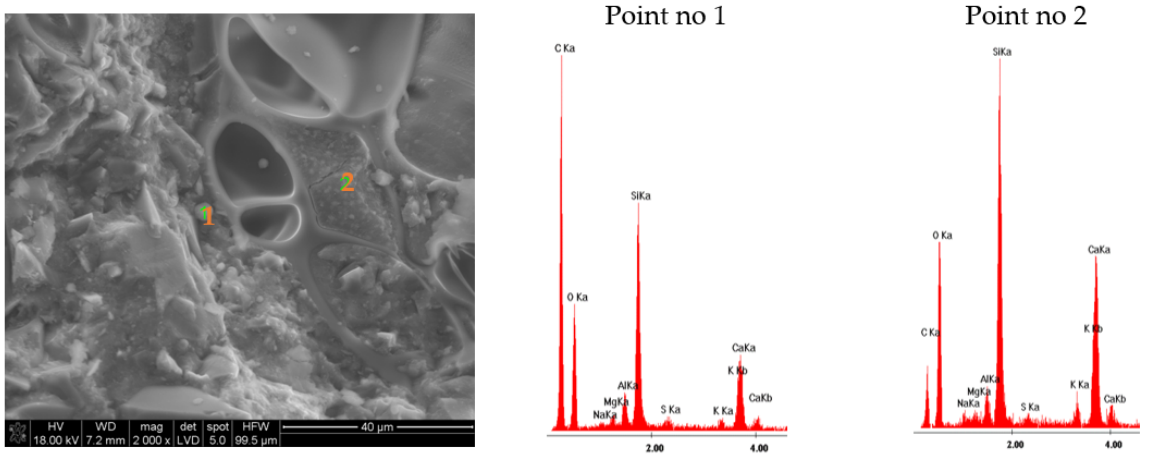
Figure 12. Microstructure of lightweight RPC with 60 vol.% of EP, cured for 28 days in 2000 times magnification with EDS analysis in point 1, 2, and 3.